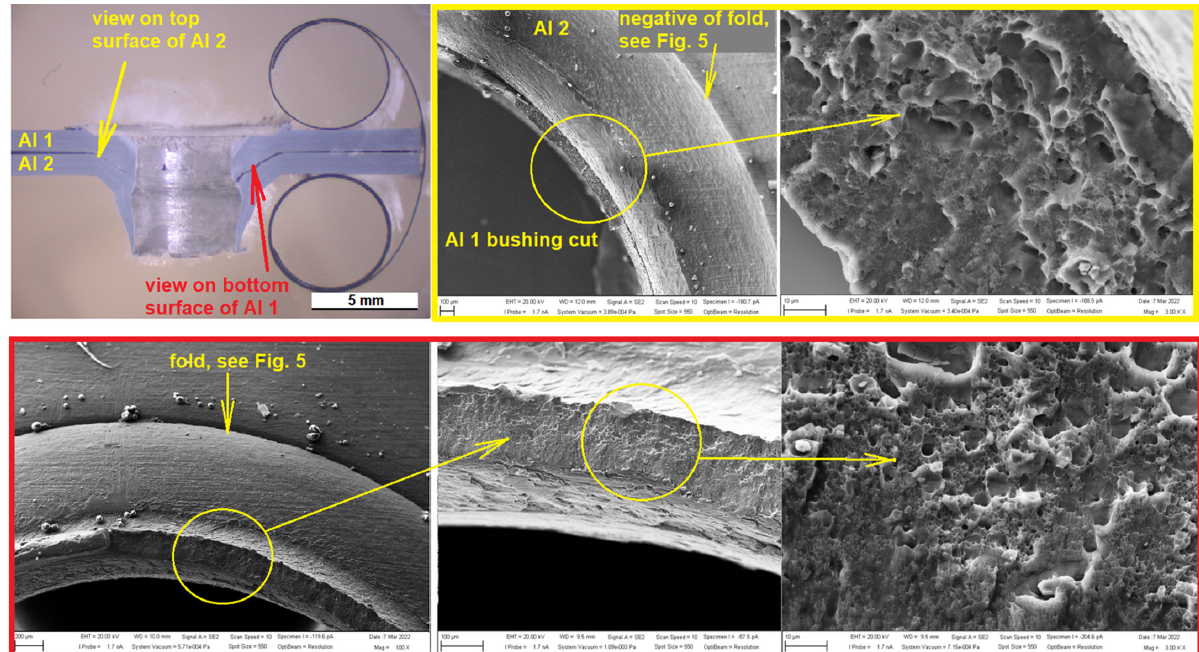
Figure 11. SEM analysis of Al-Al joint, element maps, EDS spectra, and fracture surfaces of bushing. The yellow border contains a detailed view on the top surface of the lower material. The red border contains a detailed view on the bottom surface of the upper material.